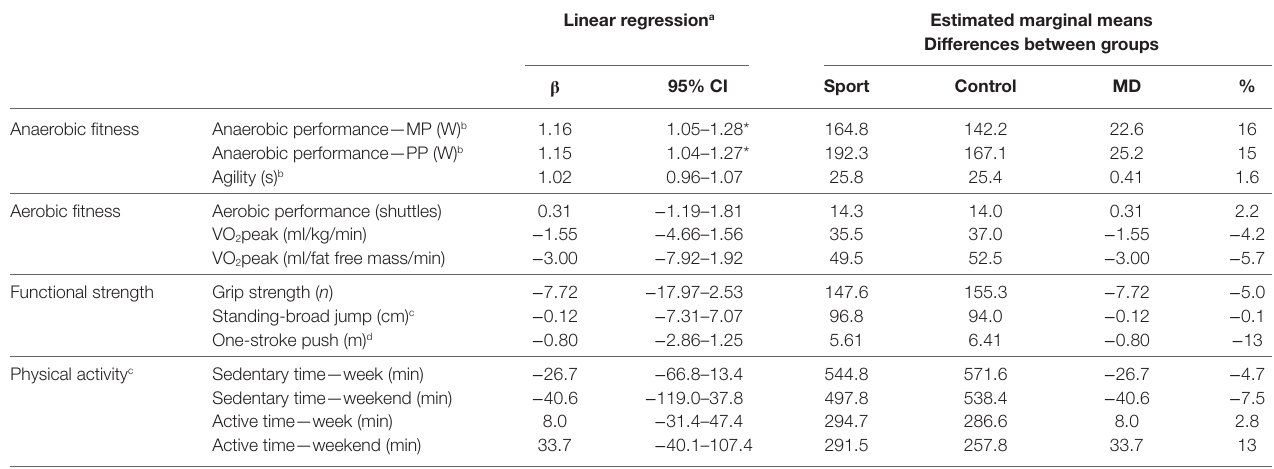
TaBlE 4 | Results from the linear regression analyses assessing the intervention effect on physical fitness and physical activity.